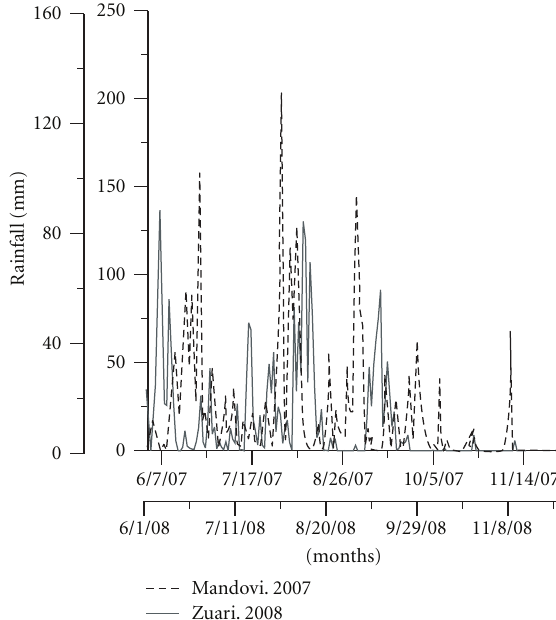
Figure 2: Rainfall pattern during the years 2007 and